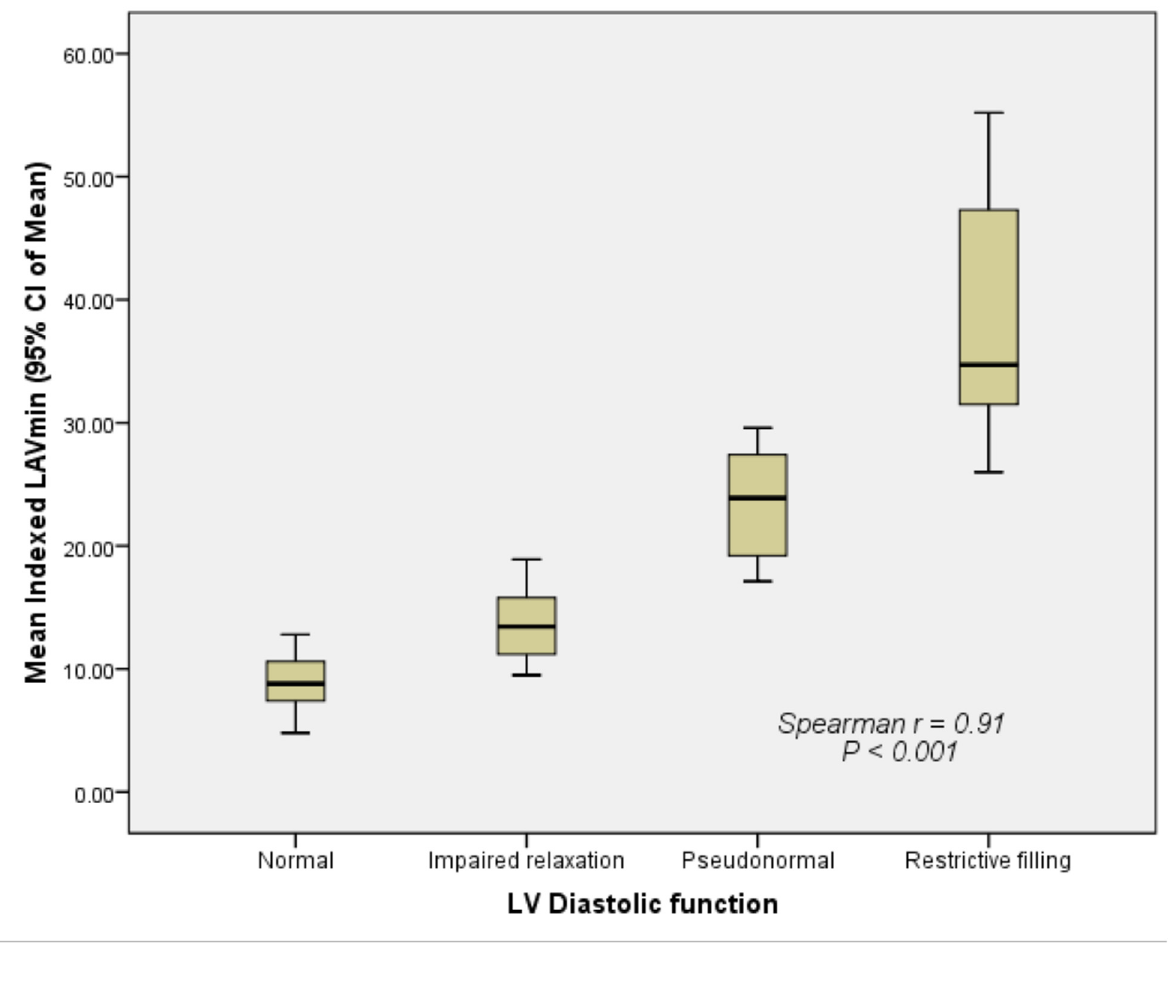
Fig 4. Correlation between the indexed LAVmin and different grades of left ventricular diastolic dysfunction. The indexed LAVmin increased significantly as LV diastolic dysfunction decreased ( P < 0.001).